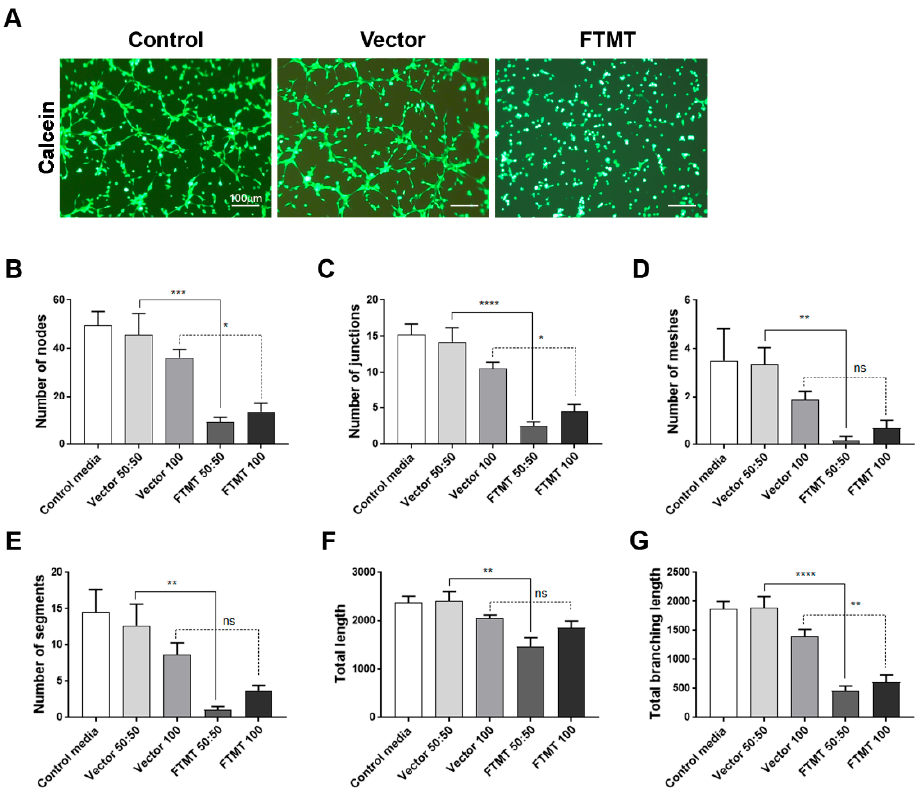
Figure 8. Conditioned media from differentiated FTMT-overexpressing ARPE-19 cells inhibit in vitro angiogenesis: ( A ) Representative calcein-AM fluorescent images of hCMEM/3D endothelial cell tube formation after 6 h in indicated condition media samples. Scale bars represent 100 μ m. ( B – G ) Bar charts showing effects at 6 h on hCMEM/3D tube formation parameters of control media, undiluted (vector 100) and diluted (vector 50:50) vector transfected cell conditioned media, and undiluted (FTMT 100) and diluted (FTMT 50:50) FTMT transfected cell conditioned media. Results represent mean + S.E.M. of 2 replicate experiments with 4 measurements per treatment ( n = 8). Data were analyzed by one-way ANOVA with Sidak’s test (* p < 0.05; ** p < 0.01, *** p < 0.001, and **** p < 0.0001, n = 8).